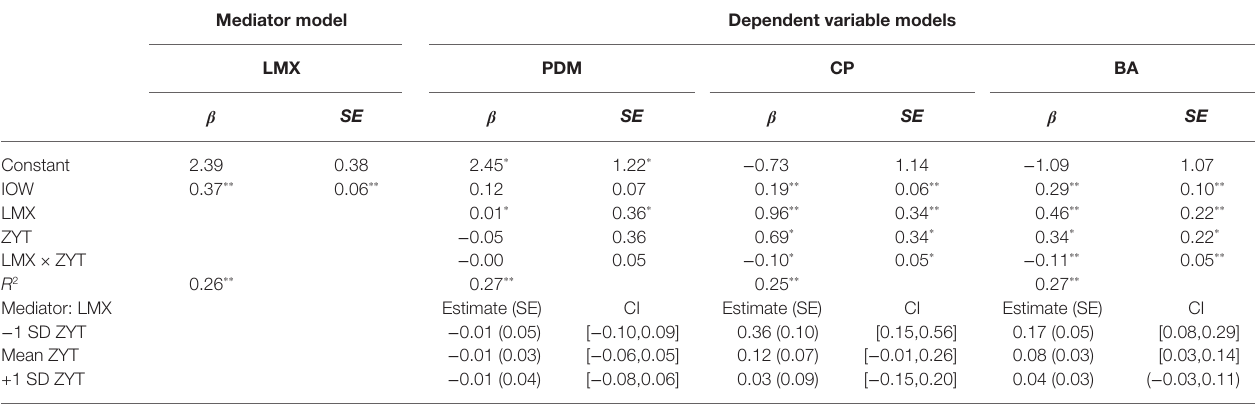
TABLE 3 | Tests of moderated mediation. Mediator model Dependent variable